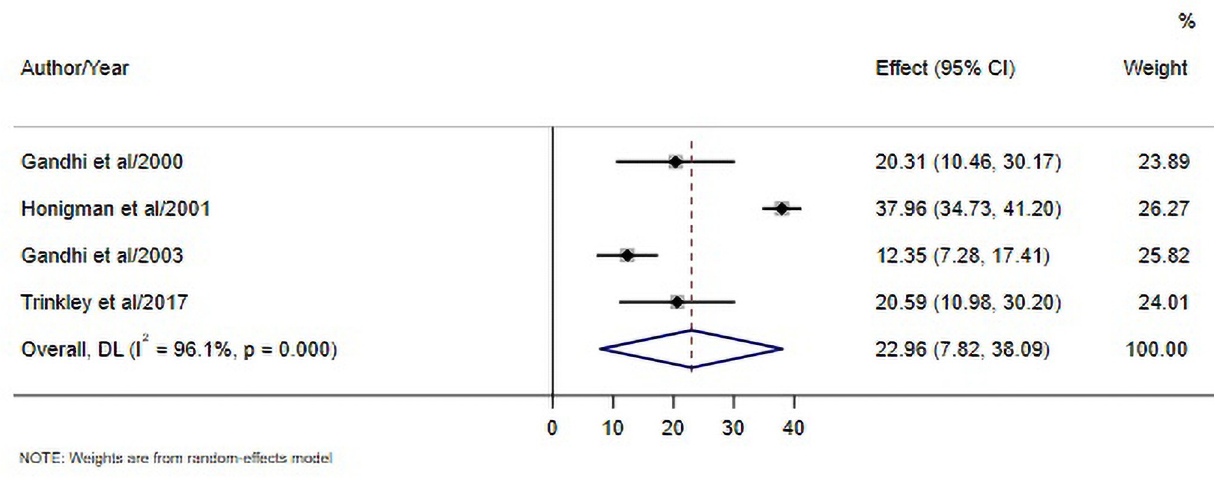
Fig 3. Percentage of preventable ADRs in the primary care setting.